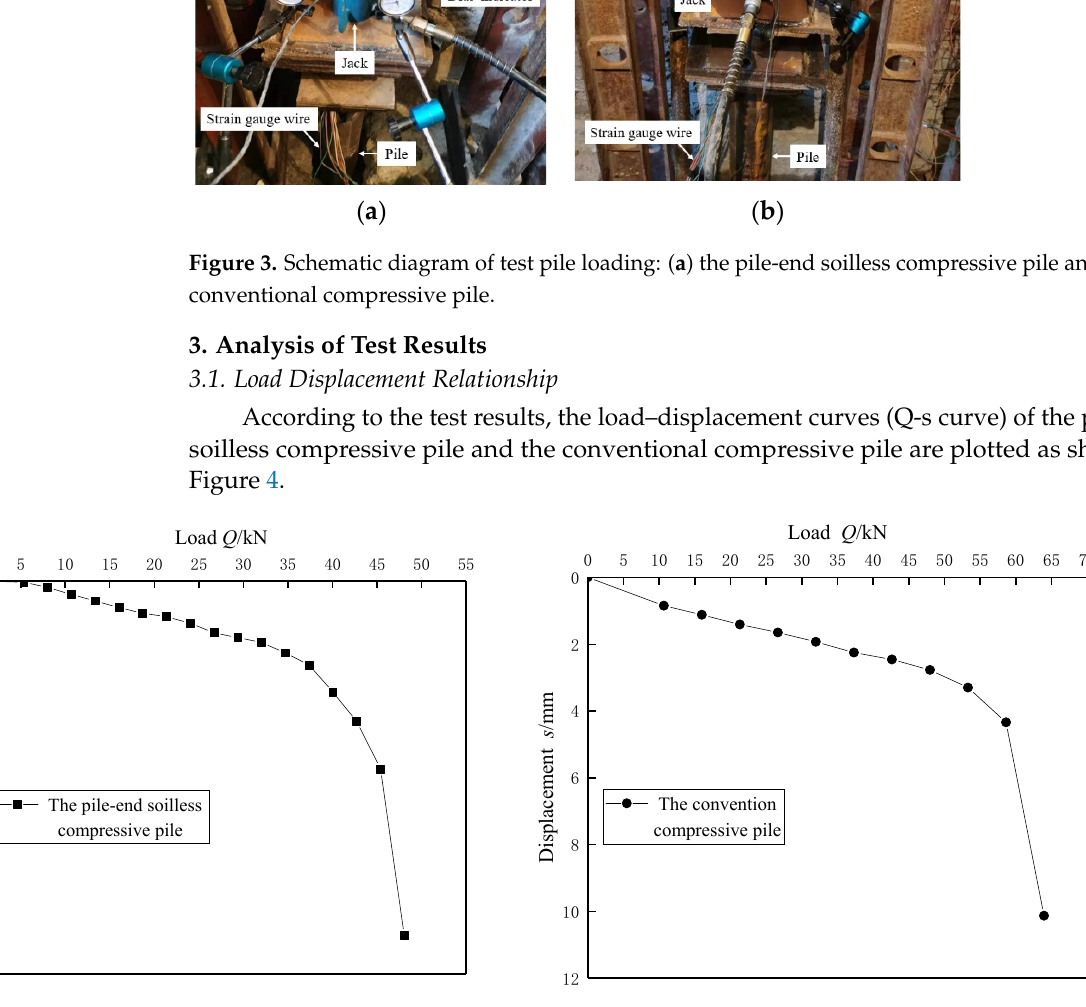
Figure 4. Q-s curve of test pile: ( a ) the pile-end soilless compressive pile and ( b ) the conventional compressive pile.